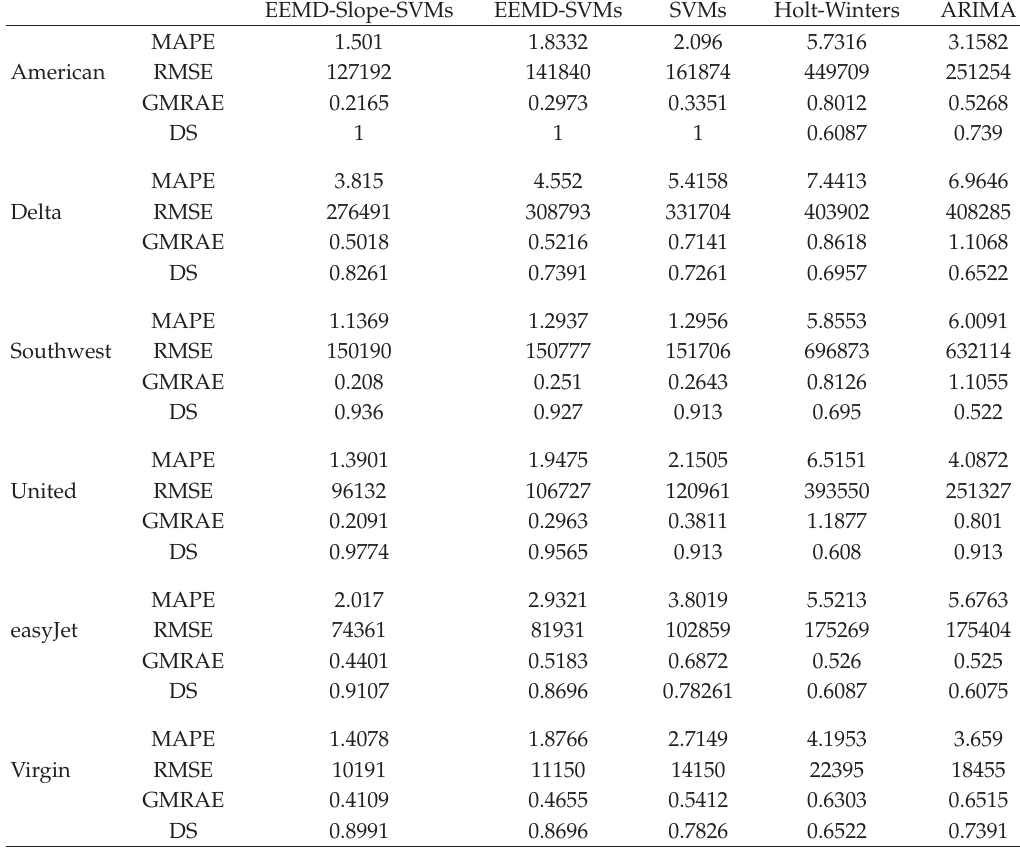
Table 1: Forecasting performances of all models across all the data series.